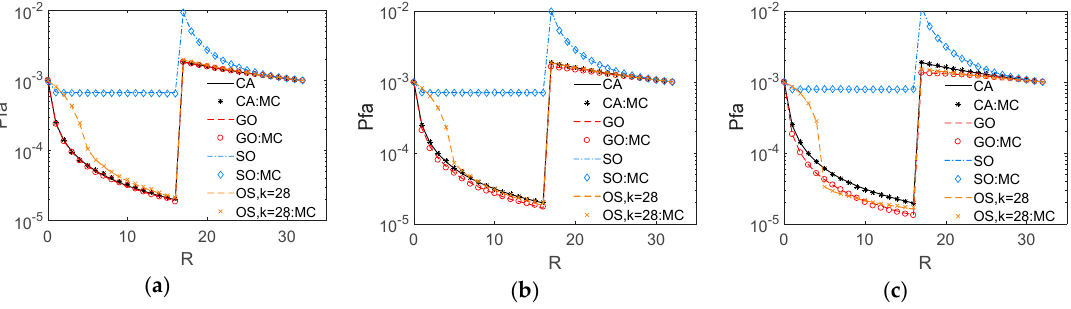
Figure 7. The Pds of the different detectors versus parameter R when α is set to 0.2, 0.5 and 0.8, respectively. The parameters are N = 32, γ = 1 and µ = 100 and designed Pfa = 10 − 3 and